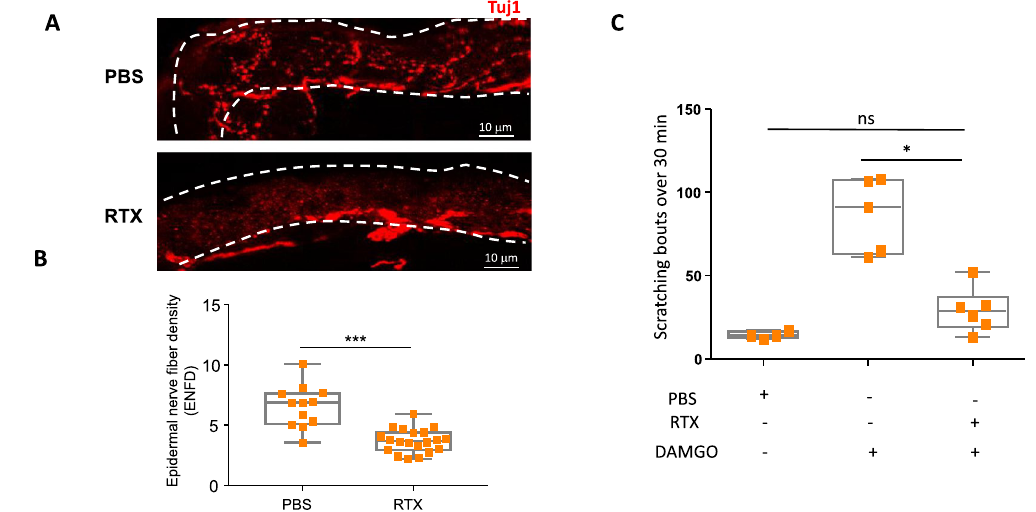
Figure 5. TRPV1-expressing C-fibers are required for DAMGO-induced itch ( A ) Representative images and ( B ) quantification of intraepidermal Tuj1 + nerve fiber density per 100 μ m of skin tissue, between PBS and RTX (three consecutive injections, one day apart: 30, 70 and 100 µ g/mL) treated mice. Dotted line delineates the epidermis. Statistical analysis were performed using Mann Whitney U test ( *** p < 0.001 PBS versus RTX). ( C ) Scratching bouts evoked by intradermal injections of either PBS or DAMGO (200 µ M) in WT (PBS; n = 4, DAMGO; n = 5) and RTX-treated mice (n = 6). Results are represented as Whiskers-dot plot (Min-Mean-Max) and each symbol represents an individual mouse. Statistical analysis were performed using Kruskall-Wallis followed by post-hoc Dunn’s test ( * p < 0.05 PBS + DAMGO versus RTX + DAMGO).